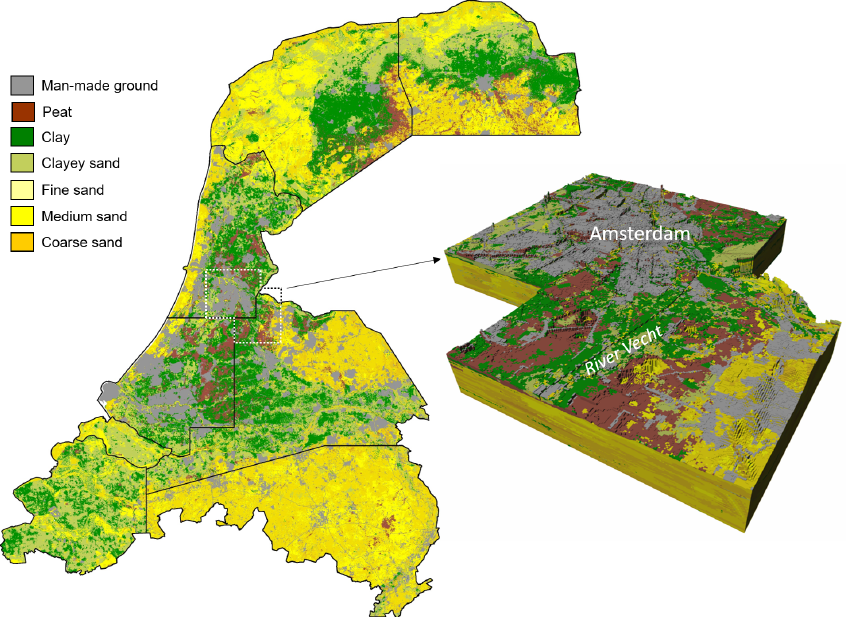
Figure 2. Overview of the GeoTOP 3D geological subsurface model (©TNO Geological Survey of the Netherlands) with (a) . The eight areas modelled so far, and (b) . A detailed 3D example of a part of the coastal plain exemplifying its lithology. Man-made ground primarily encompasses anthropogenic